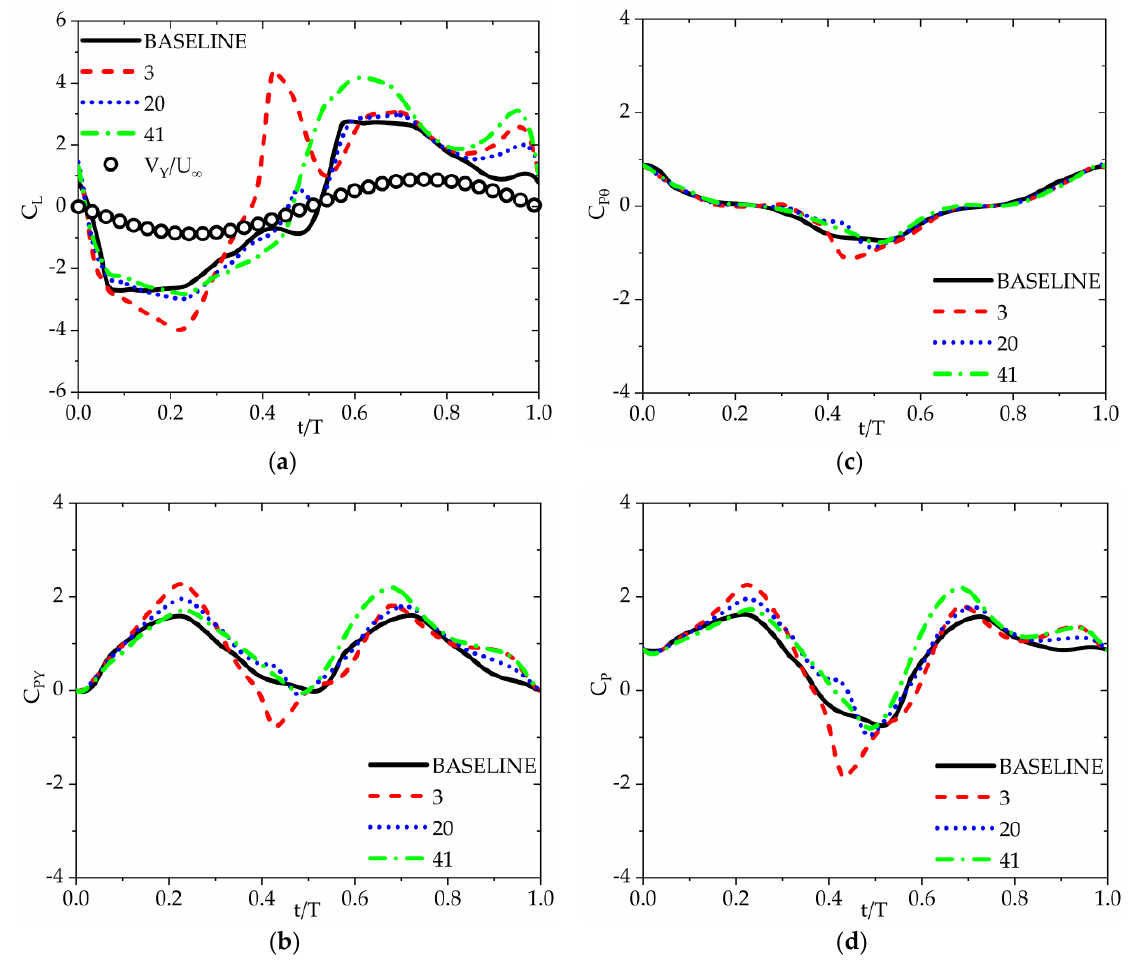
Figure 13. A comparison of the instantaneous lift and power coefficients of a hydrofoil with an up- stream deflector at different values of deflector – hydrofoil spacing J * . ( a ) Lift coefficient. ( b ) Heave upstream deflector at different values of deflector–hydrofoil spacing J *. ( a ) Lift coefficient. ( b ) Heave power coefficient. ( c ) Pitch power coefficient. ( d ) Net power coefficient. power coefficient. ( c ) Pitch power coefficient. ( d ) Net power